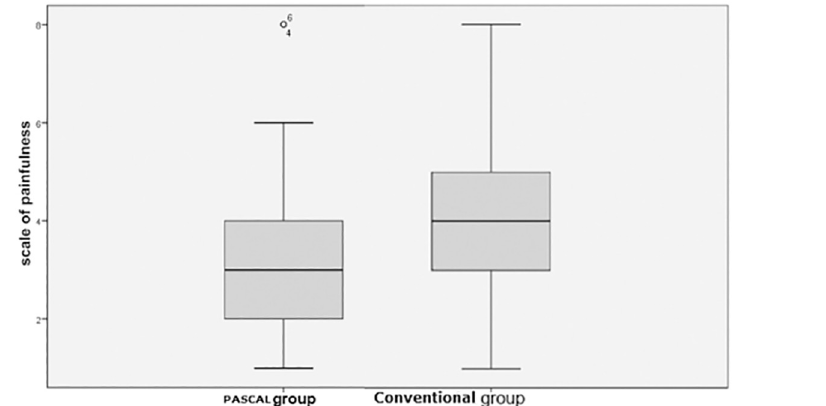
Fig 2. Subjective evaluation of pain intensity–Pascal and Conventional